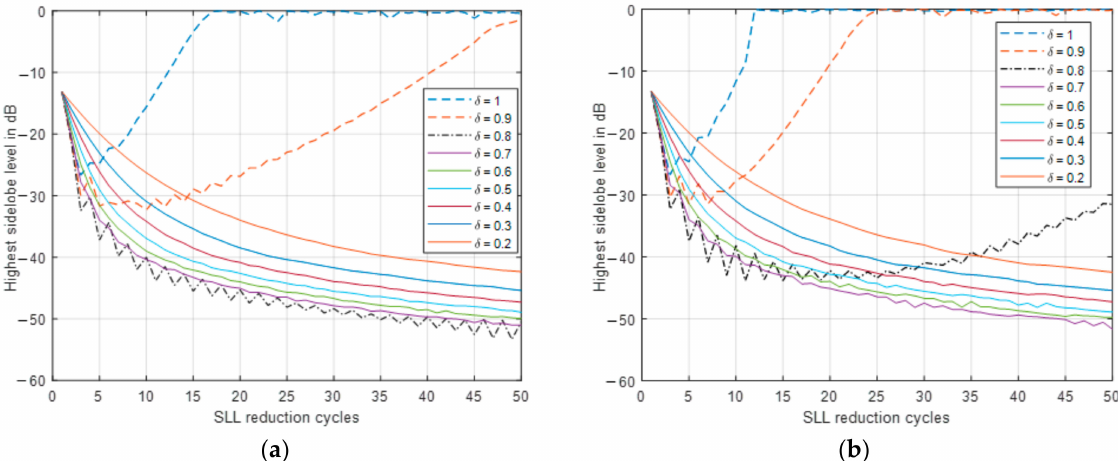
Figure 3. Convergence behavior of the SSR algorithms with the number of SLL reduction cycles at different values of convergence behavior for: ( a ) 16-element linear array, ( b ) 32-element linear